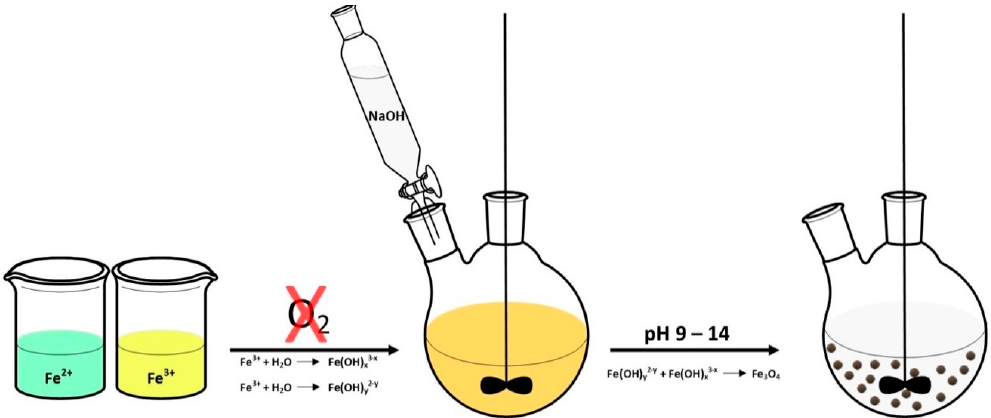
Figure 2. Synthesis of iron oxide nanoparticles by co-precipitation.